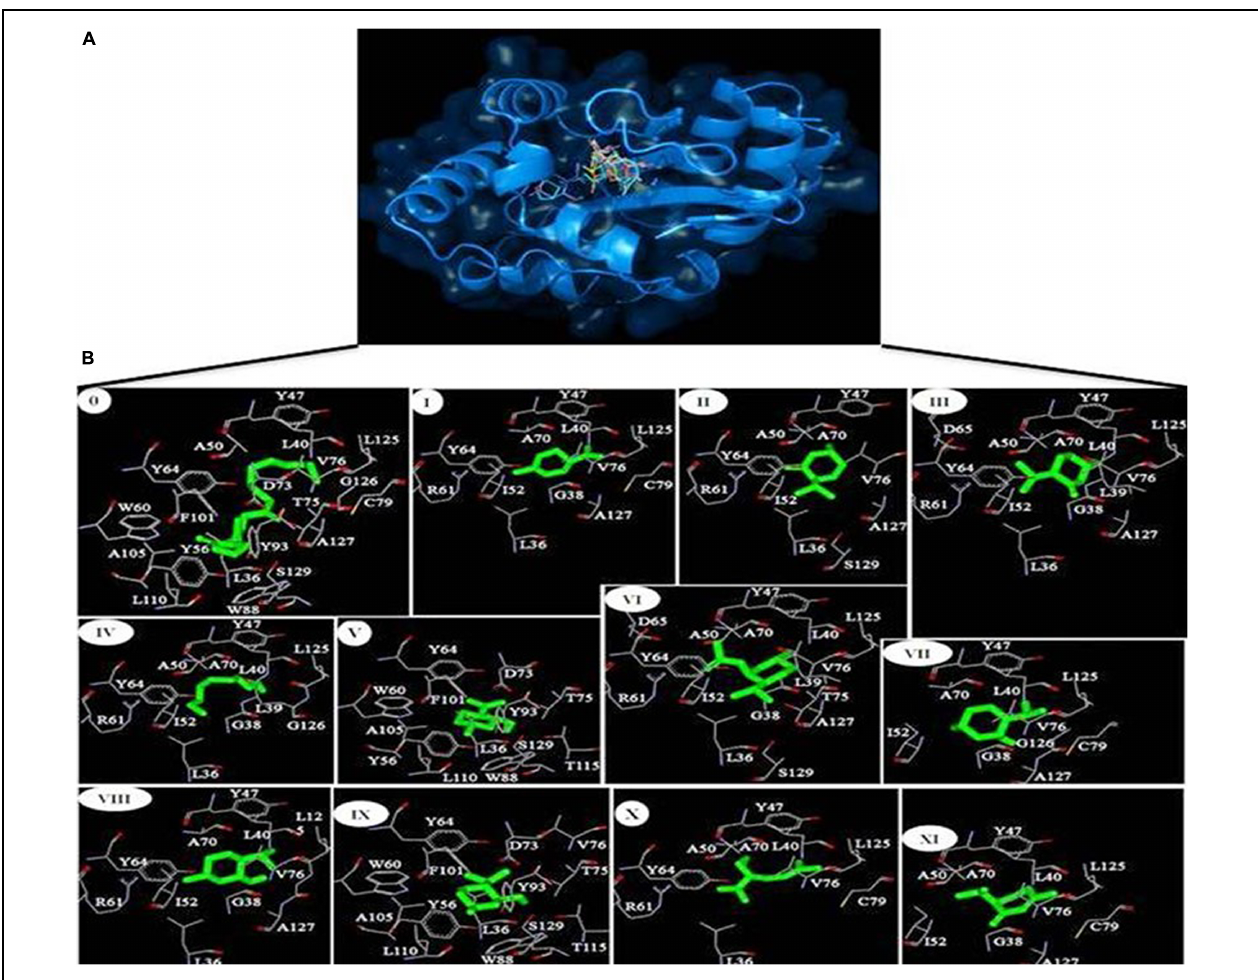
FIGURE 2 | (A) Inhibitors obtained from the essential oil of Mentha piperita as well as the natural autoinducer 3-oxo-C12-HSL acyl homoserine lactone (AHL) are docked in the hydrophobic pocket of LasR. (B) Residues involved in the interaction of LasR-inhibitors as revealed from